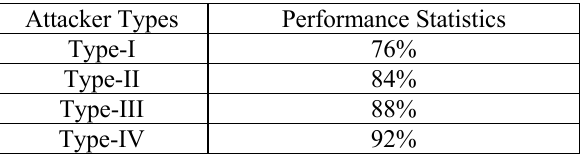
Table 9. The performance statistics for all attacker types